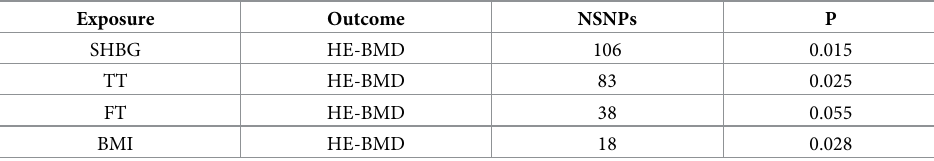
Table 2. Causal relationships of factors on HE-BMD by multivariable